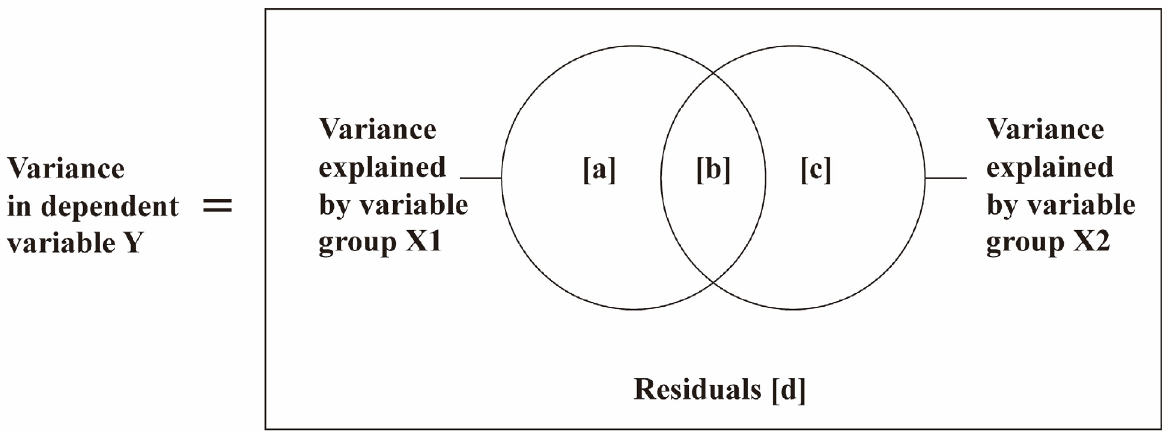
Figure 4. Variance partitioning analysis of a dependent variable Y between two groups of explanatory variables X1 and X2.